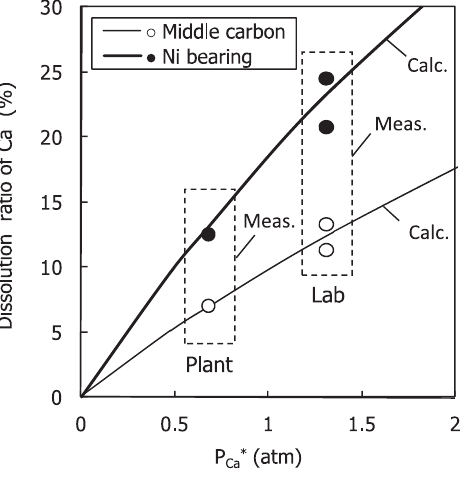
Fig. 8: Dissolution ratios of calcium as a function of P Ca